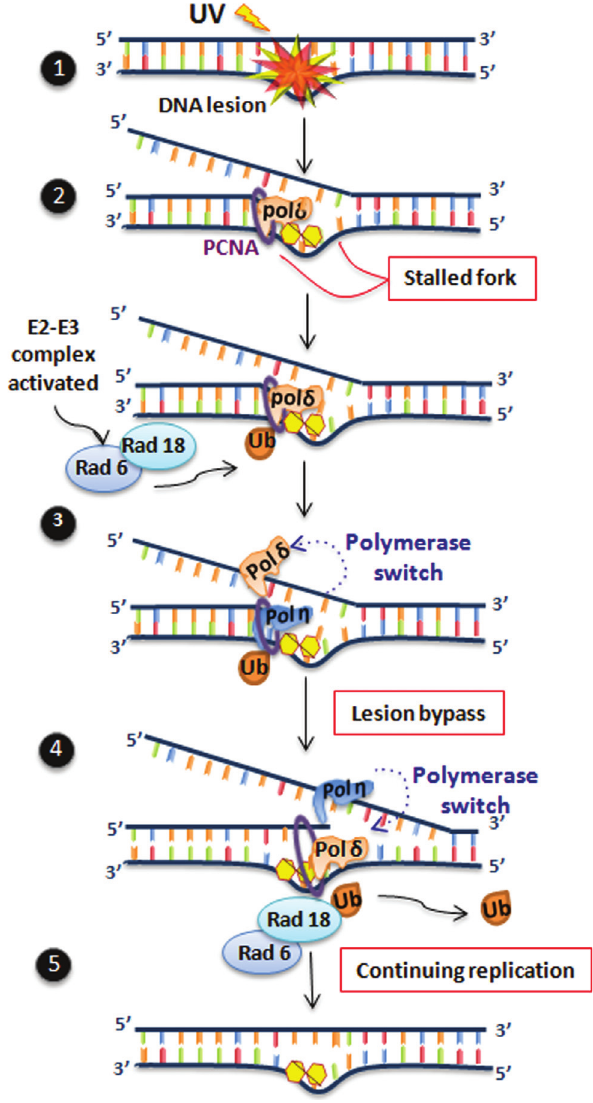
Figure 3 - Schematic representation of translesion synthesis (TLS) by Pol (cid:4) . The replication fork is blocked by DNA damage, and after a series of events (including the monoubiquitination of PCNA), a polymerase switch provides DNA polymerase eta (XP-V) with an opportunity to bypass the lesion.Inthisfigure,onlyonestrand(leadingstrand)isrepresented.Atthe endoftheprocessthelesionremainsintheDNA,butthereplicationofthis molecule can